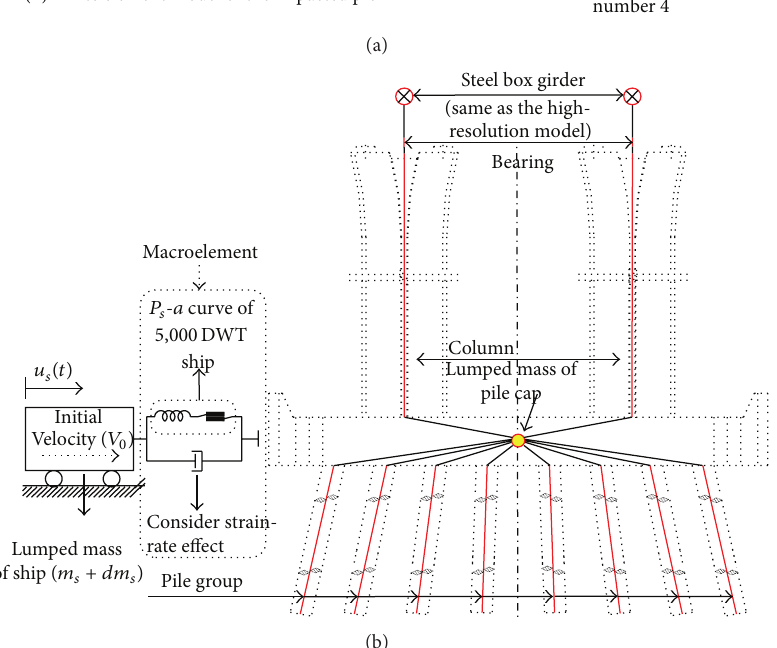
arrangement, typical vessel transit speed, and overall length of the ship using the method in AASHTO [3]. The material parameters are tabulated in Table